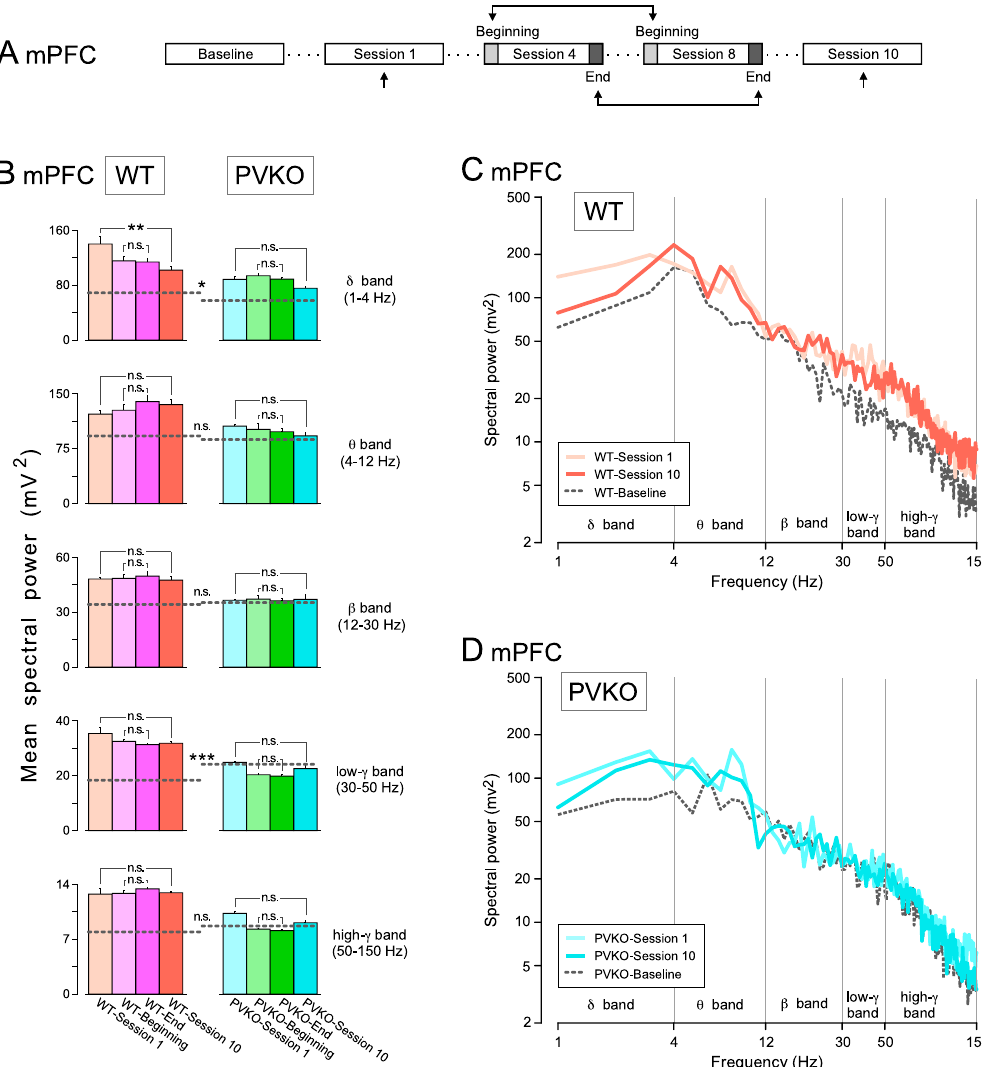
Figure 6. Spectral analyses of LFPs recorded in the mPFC across the successive operant conditioning sessions. ( A ) Experimental design. ( B ) Power histograms for the five selected frequency bands δ (1–4 Hz), θ (4–12 Hz), β (12–35 Hz), low − γ (30–50 Hz) and high − γ (50–100 Hz) of LFPs recorded in the mPFC from WT (orange and pink) and PVKO (blue and green bars) mice during the 1st session , at the beginning of the 4th–8th sessions , at the end of the 4th–8th sessions and during the 10th sessions . Differences between the spectral powers in the selected frequency bands are indicated at the enclosed histograms for both WT and PVKO mice. The dotted lines across the histograms of each frequency band correspond to the mean power of the baseline condition for the corresponding group of mice. Note the larger spectral powers presented by LFPs collected from WT mice for the five selected frequency bands. Tukey-Kramer multiple comparisons test: n.s., non-significant difference; * P < 0.05 ; ** P < 0.01 ; *** P < 0.001 (see Supplementary Tables S4.1–S4.3). ( C ) Mean power spectra of LFPs recorded in the mPFC from WT mice during the baseline condition and during the 1st session (light orange trace) and during the 10th session (dark orange trace). ( D ) Mean power spectra of LFPs recorded in the mPFC from PVKO mice during the baseline condition and during the 1st session (light blue trace) and during the 10th session (dark blue